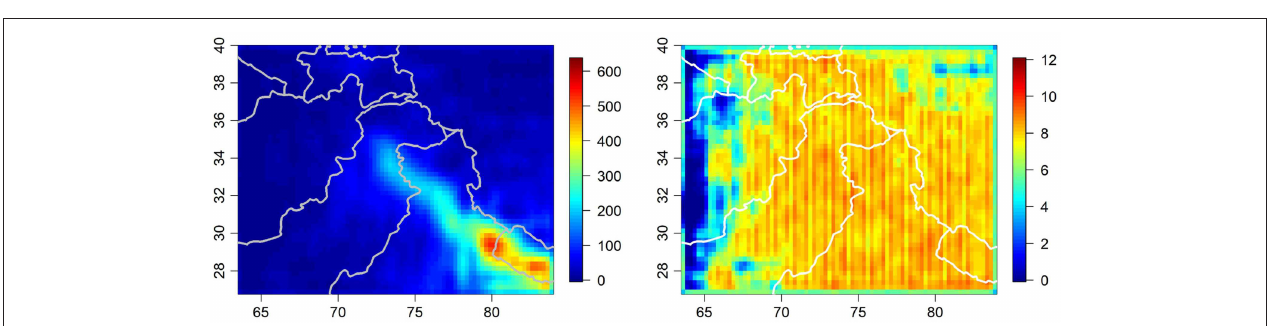
FIGURE 3 | The precipitation products for August 2000 (in mm).